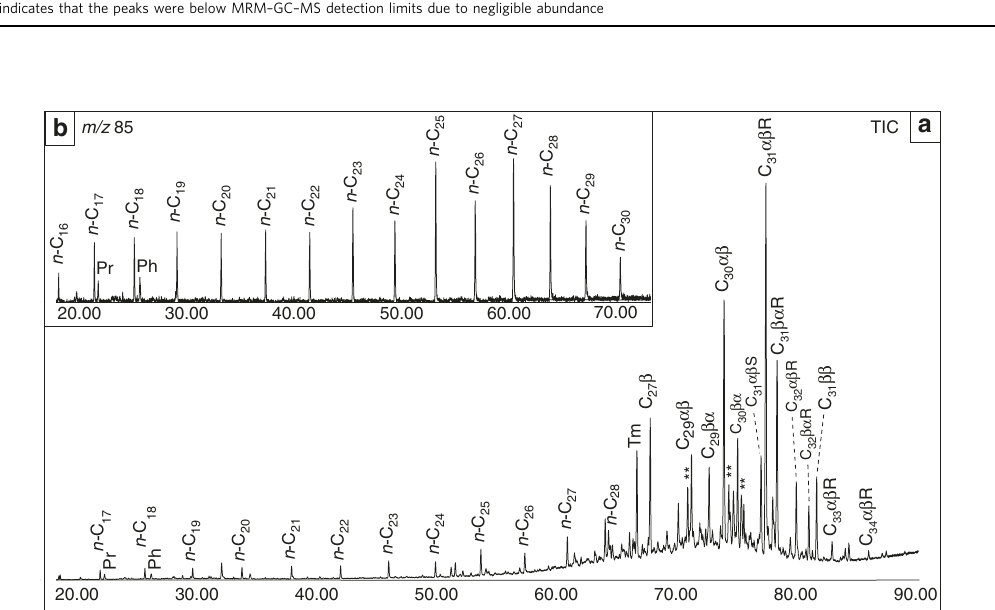
Fig. 2 Distribution of extractable aliphatic hydrocarbons for a representative sample. a Total ion chromatogram (TIC) for extractable aliphatic hydrocarbons for Lugovoe #13 – 73 m from the Redkino Horizon. The n -alkane series, pristane (Pr), phytane (Ph), and C 27 – C 34 hopanes (denoted by their total carbon number and stereochemistry at C-17, C-21, and C-22, e.g., C31 αβ R) are labeled; ** denotes C 29 and C 30 hopenes. Note the hopane abundance dominance over other alkane compound classes. b Partial 85-Da ion chromatogram shows dominance of the n -alkane series, exhibiting a discernible odd-over-even carbon-number preference in the C 22 – C 27 range, over